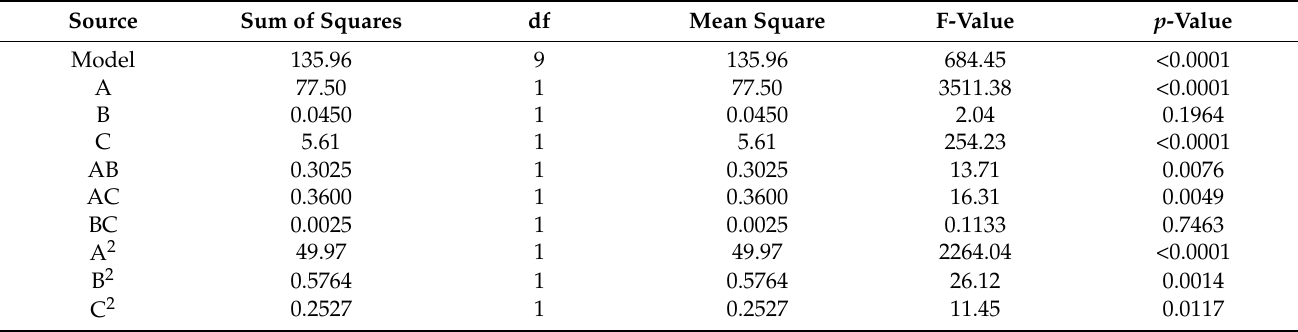
Table 6. Variance results of the quadratic model for the solid drying time.